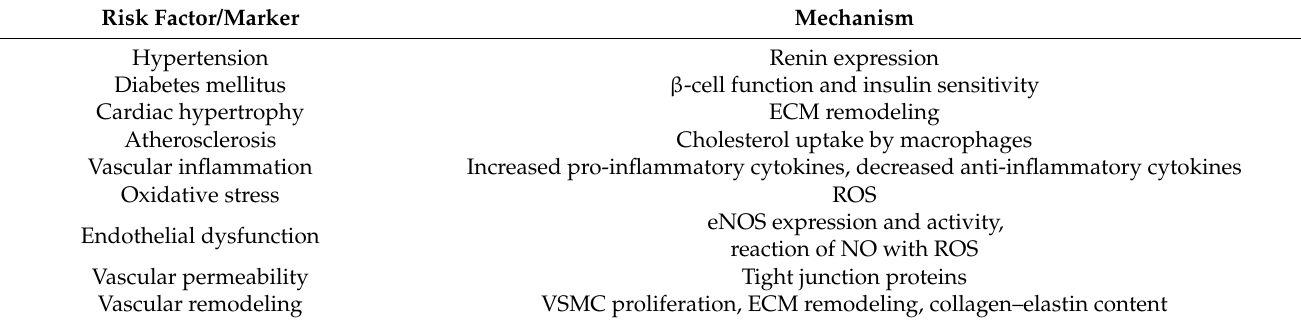
Table 2. Role of vitamin D deficiency (VDD) in the pathogenesis of cardiovascular and cerebrovascular